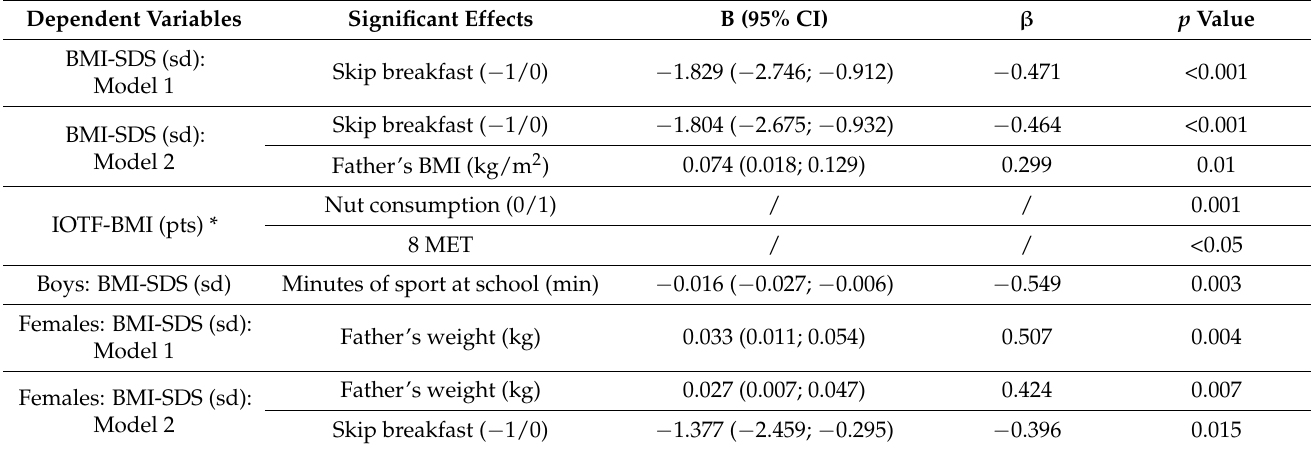
Table 4. Multiple stepwise regression analysis results of significant effects (independent variables) on BMI-SDS (dependent variable) and multiple logistic stepwise regression on IOTF-BMI.